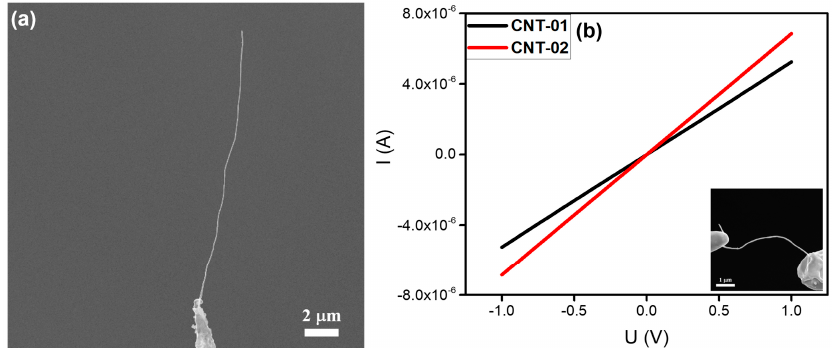
Figure 3. ( a ) SEM image of an individual carbon nanotube (CNT) welded onto a tungsten needle. ( b ) Typical current versus voltage (I-V curves) of two individual CNTs. Typical SEM image of the